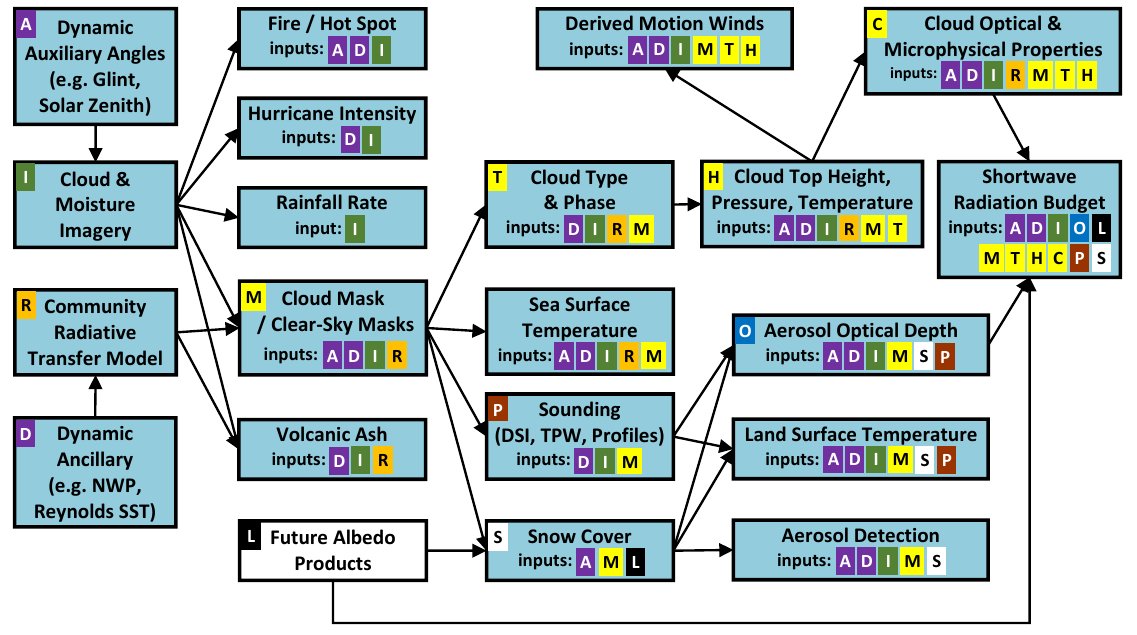
Figure 2. End-to-end algorithm precedence flow of ABI L2+ products. Each box is